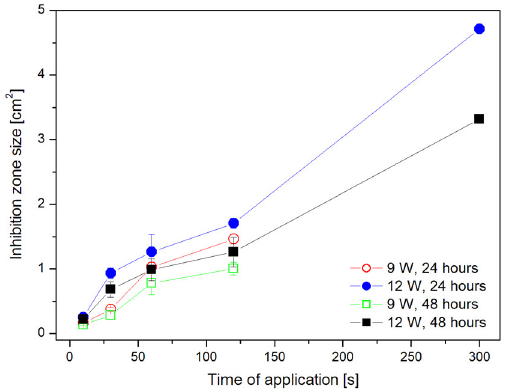
Figure 4. The dependence of the inhibition zone size on the plasma exposure time for the 10-fold dilution.